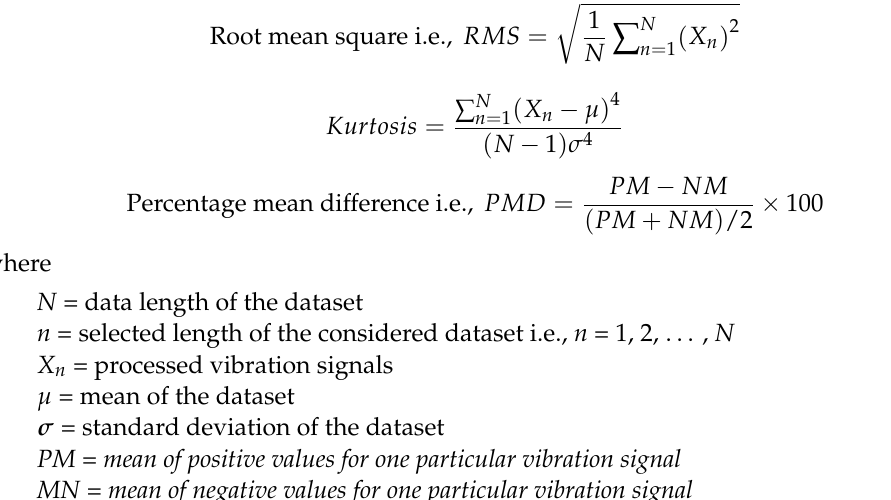
Figure 2. The locations of the accelerometer installed on the slurry pump.